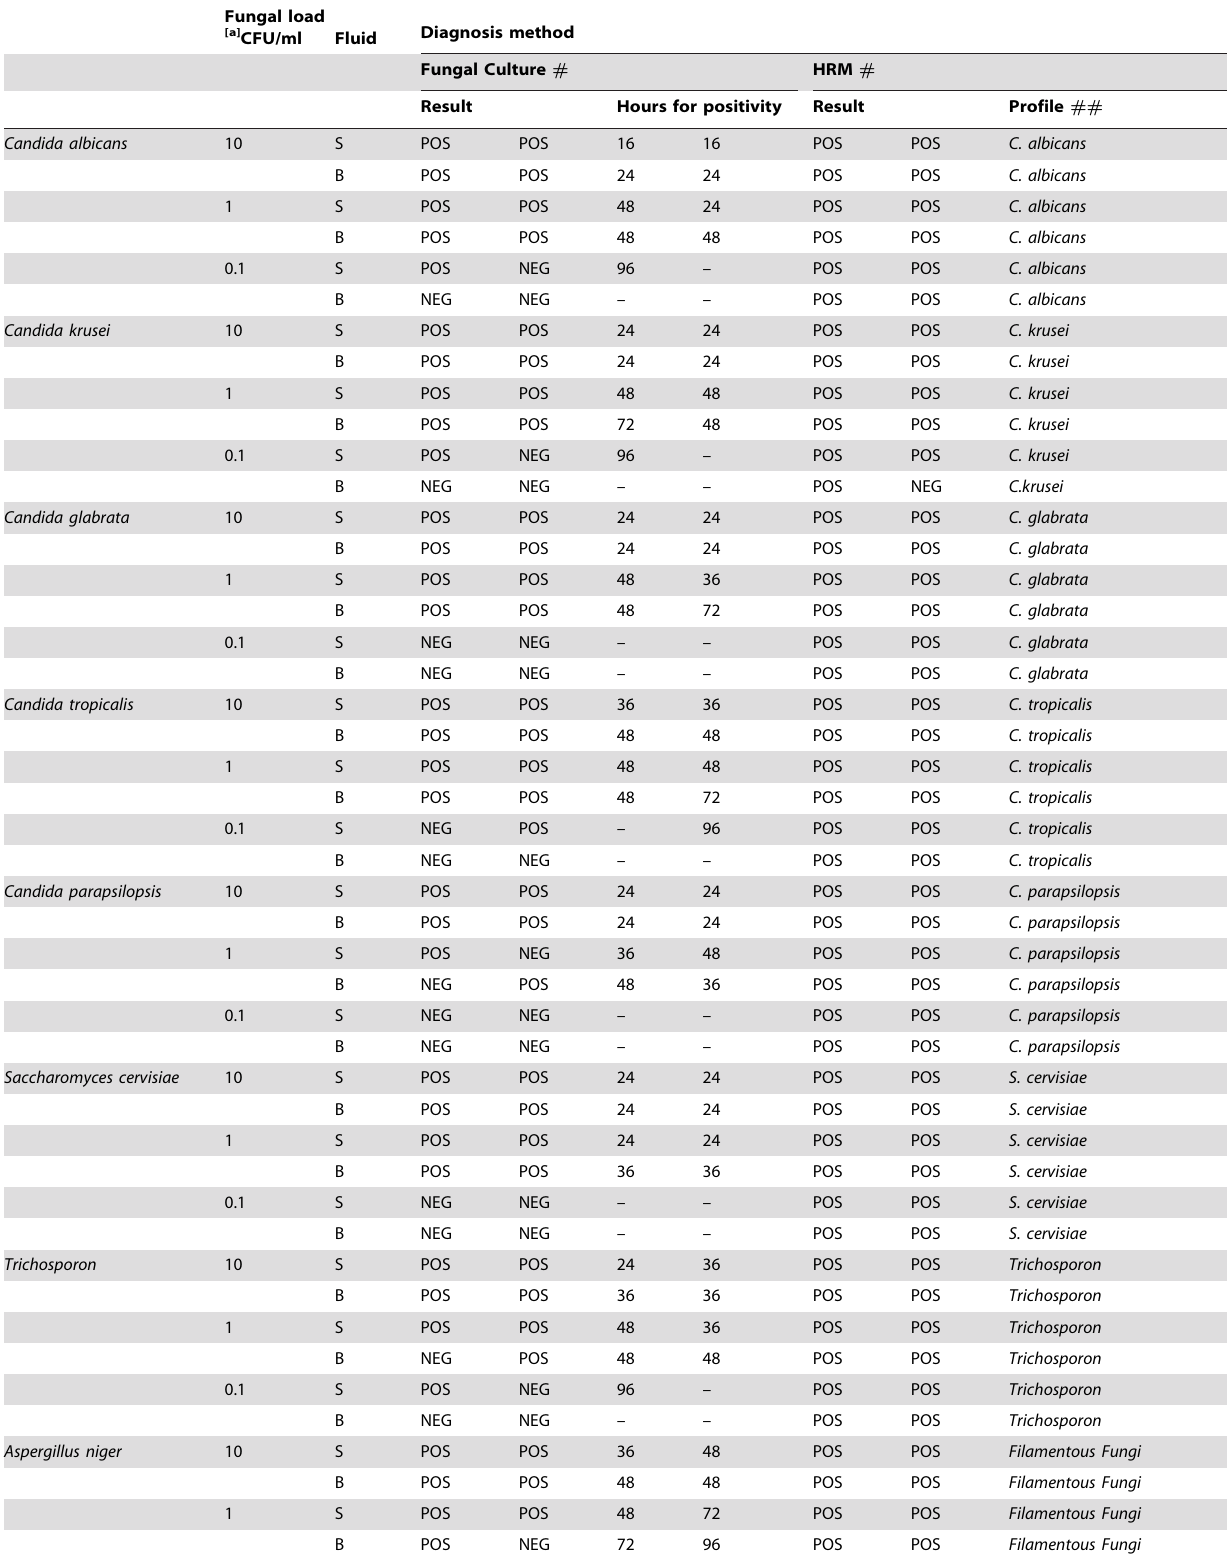
Table 3. Comparison of culture and high-resolution melting analysis (PCR-HRM) performances on experimentally infected